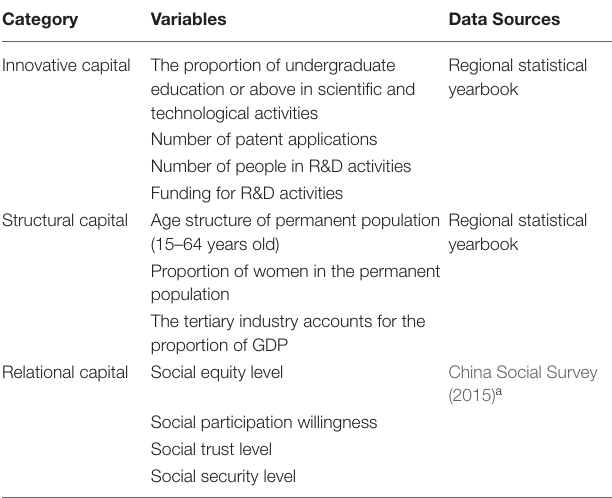
TABLE 2 | The social capital indicator